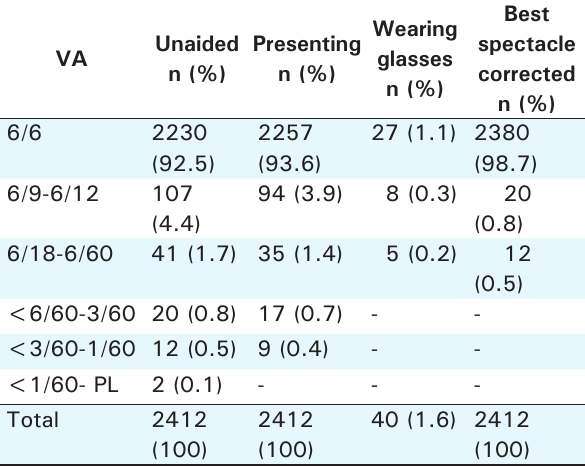
Table 2. Distribution of uncorrected, presenting and best spectacle corrected visual acuity.